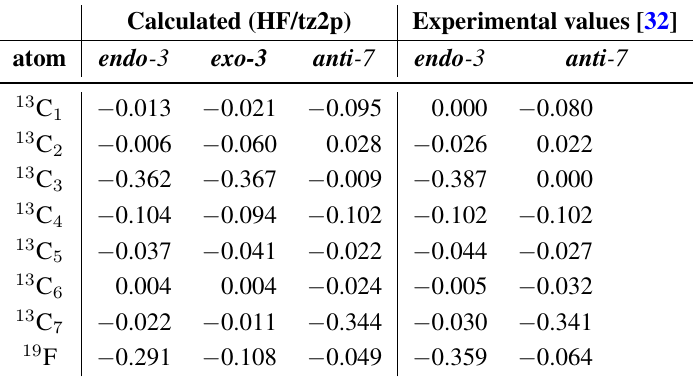
Table 2. Secondary isotope shifts of endo -2-fluoronorbornane in ppm at HF/tz2p level and for T = 300 K and experimental values with deuterium labels on different positions in the molecule. Calculated (HF/tz2p) Experimental values [32] endo